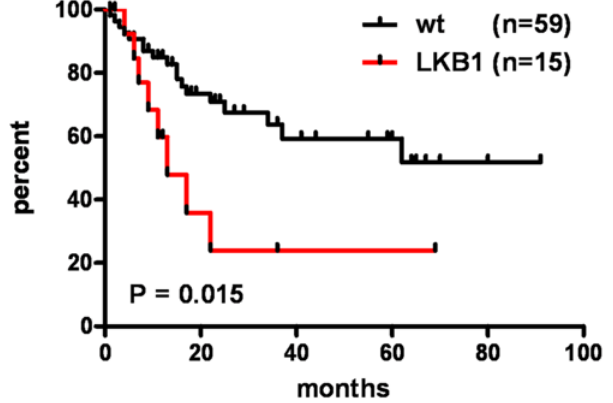
Figure 5. Progression-free survival of patients with LKB1 -wild type vs. LKB1 -mutant tumors. Kaplan-Meier curves show the percentage of patients with disease progression over time. The curves compare patients whose tumors were heterozygous or homozygous for mutations/deletions ( LKB1 ) vs. patients with no mutations/deletions (wt). Patients with . 1 follow-up visit were included in the analysis. P value per log-rank test.